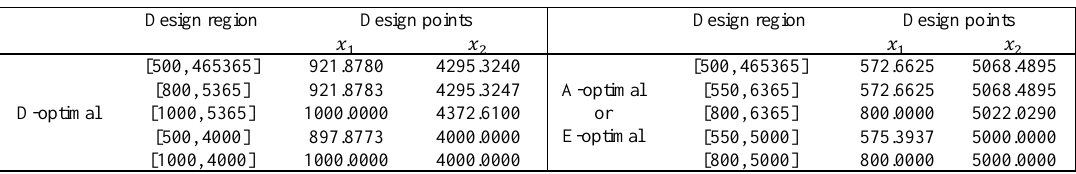
weights 𝑤 = 0.5, 1